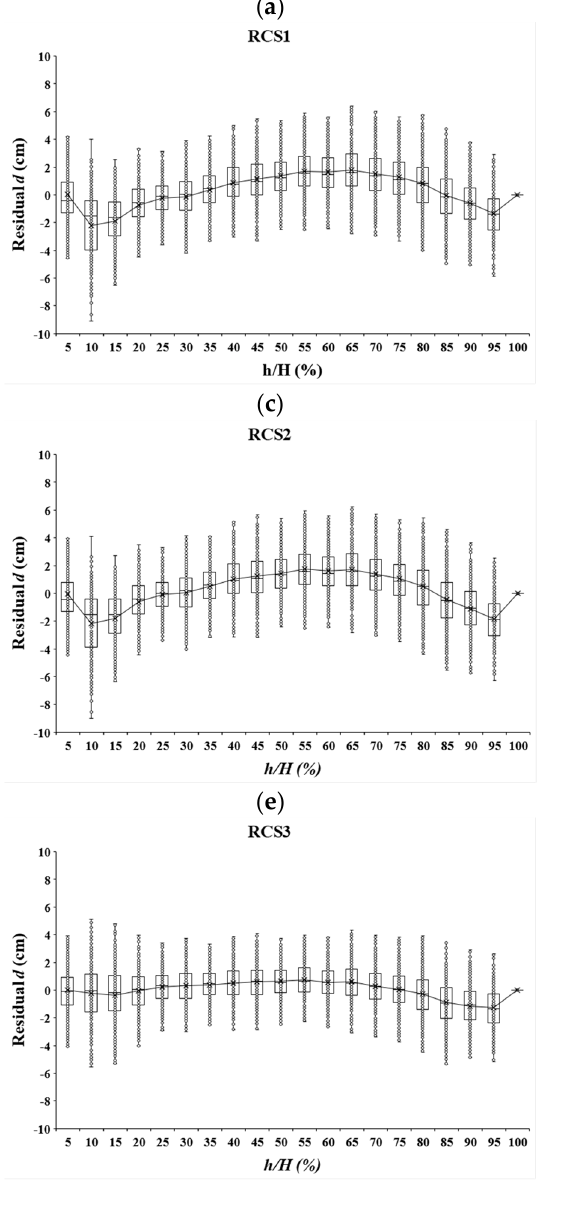
Figure 3. Distribution of residuals of d and V m of the reduced compatible systems RCS1 ( a , b ), RCS2 ( c , d ), and RCS3 ( e , f ); “o” is the mean, “-” is the median, and “I” is the error bar representing the interquartile range (Q1–Q3).